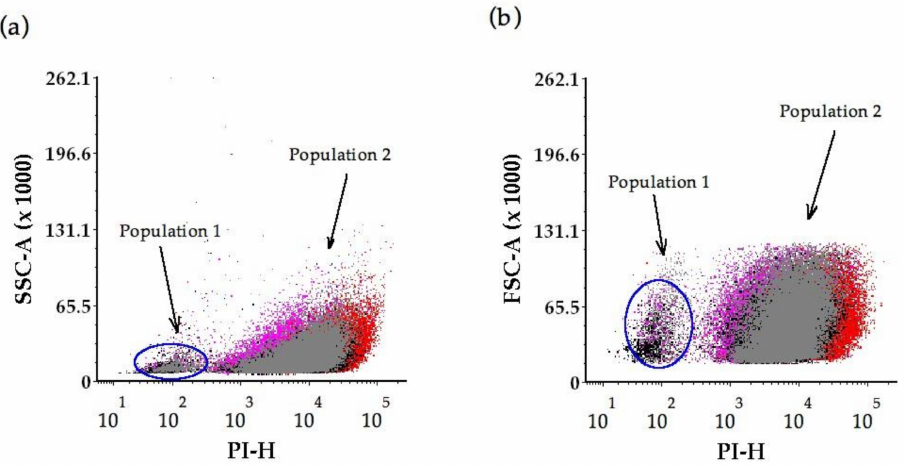
Figure 6. Bimodal distribution of PI fluorescence depicted for S. cerevisiae cells at time 0 of flow cytometry physical parame- ters ( a ) side scatter (SSC-A) parameter, and ( b ) forward scatter (FSC-A) parameter. Dots represent yeast replicates from the control (magenta); ultrasound treatment (black), β -glucanase enzyme treatment (grey) and microwave treatment